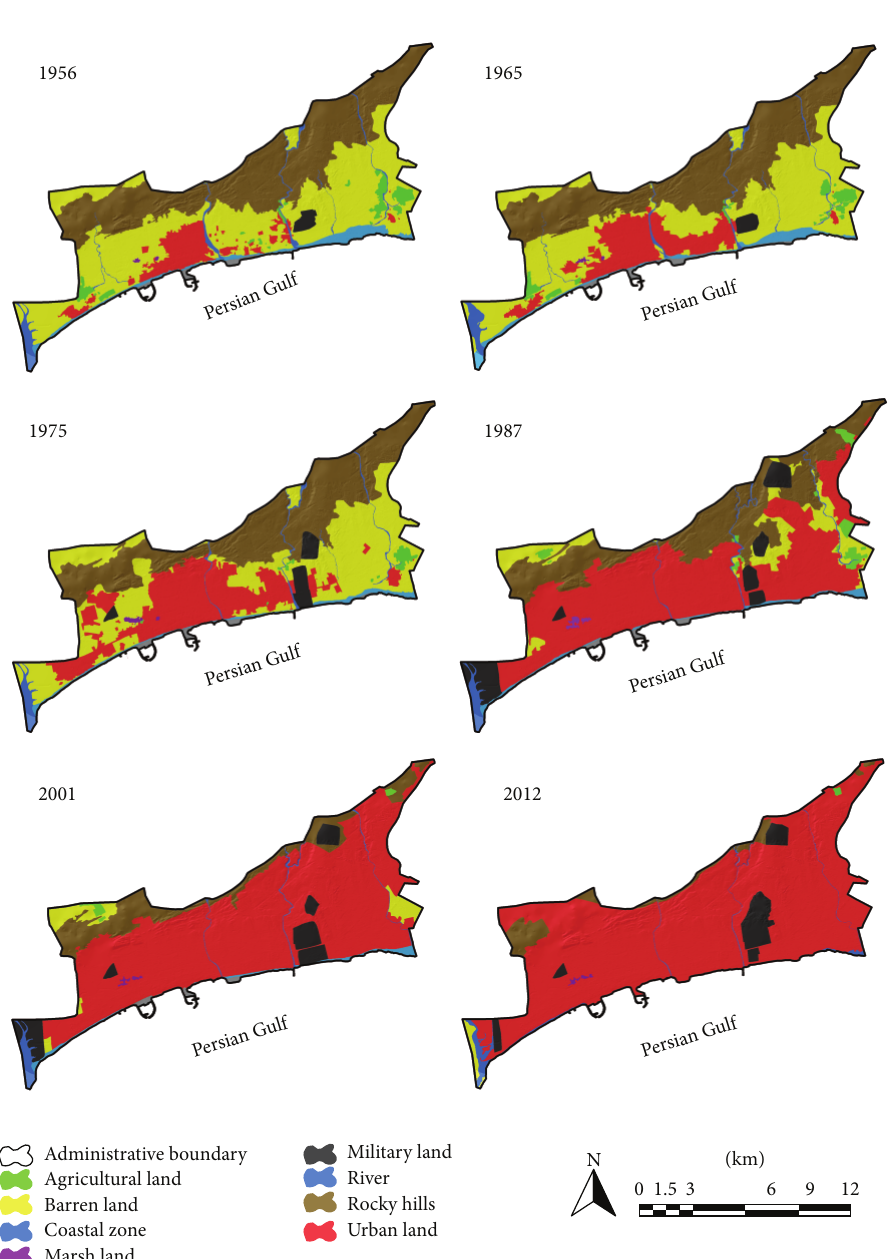
Figure 6: Land use changes maps